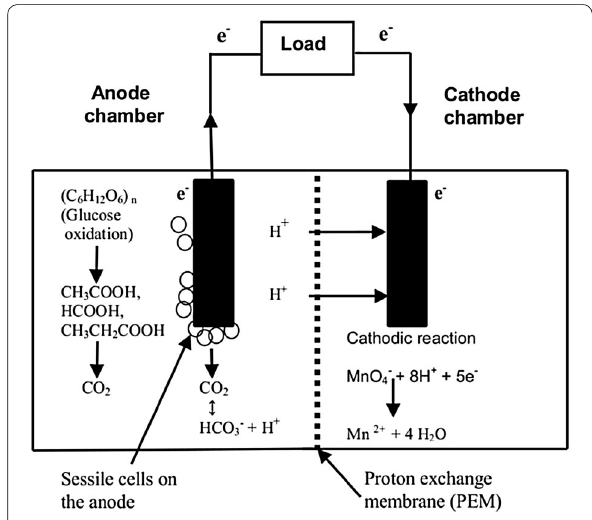
Fig. 1 A schematic diagram of a double-chamber PDWW. Electron flows from anode to cathode are through external load as indicated with arrows. Black bars in chambers are the electrodes. Oxidation reaction of PDWW in the anode was shown at the anode while the reduction reaction in the cathode was shown at the cathode. The directions of the flow of protons from anode to cathode through PEM were shown by arrows